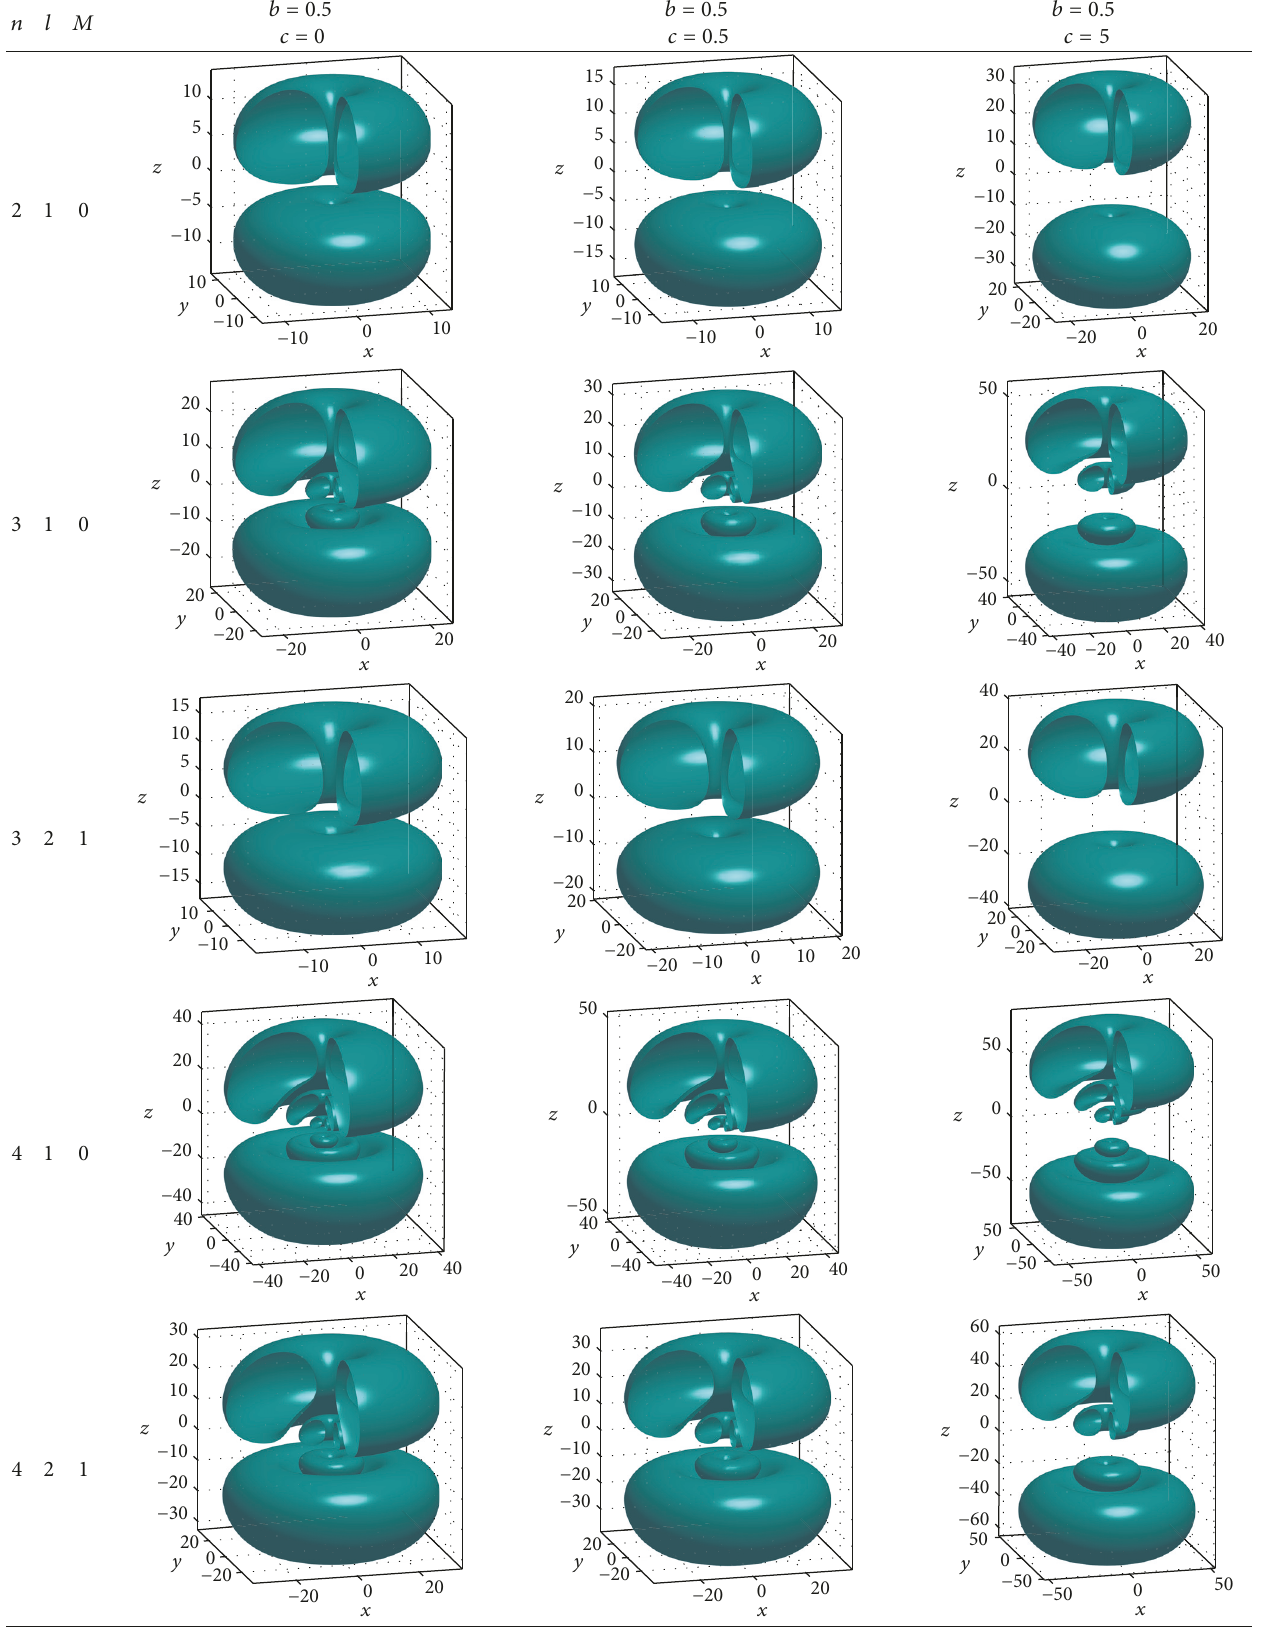
Table 1: The isosurface SPDs with a section